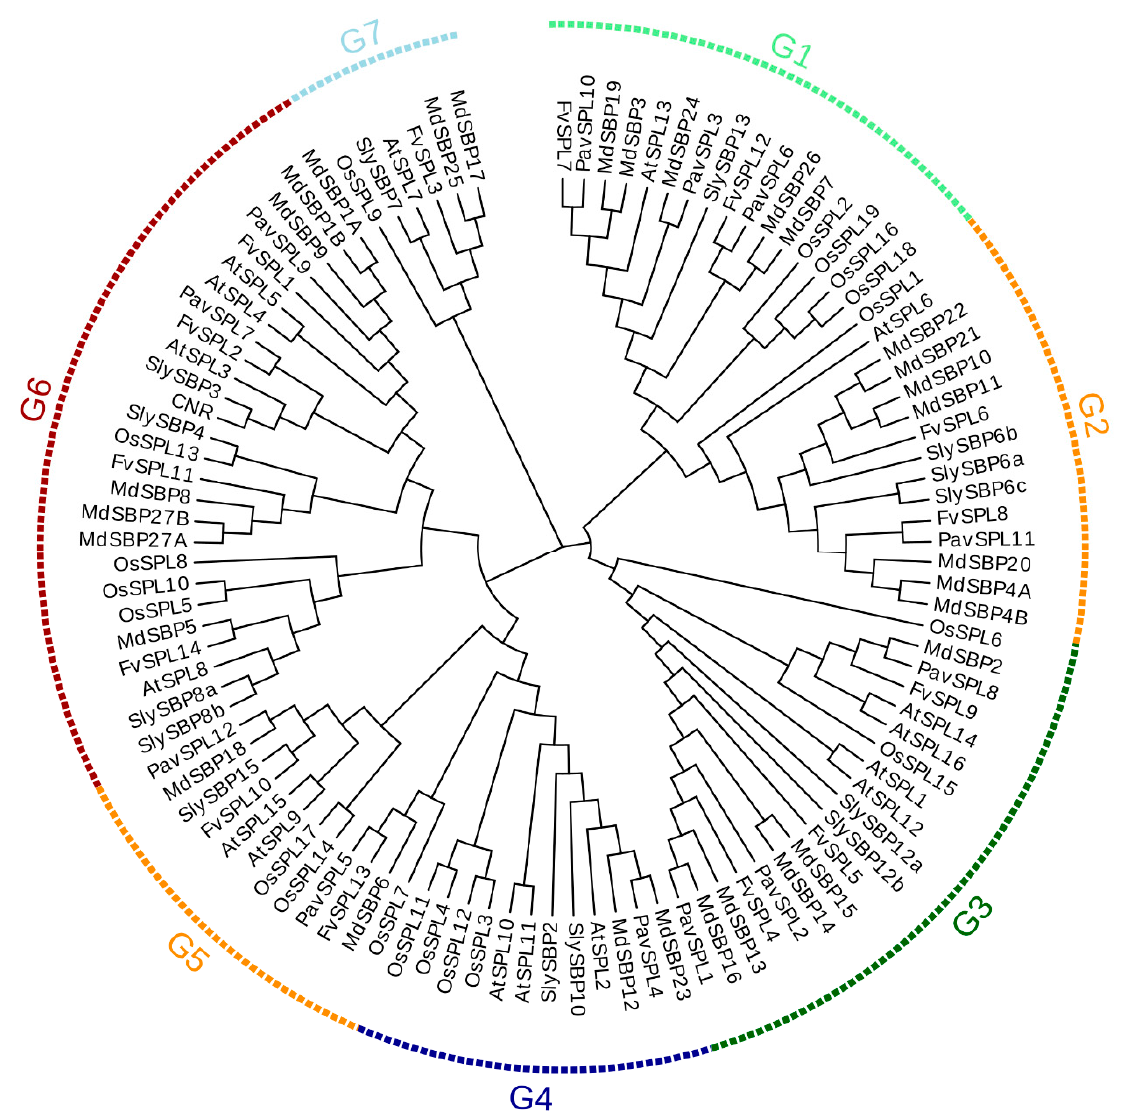
Figure 3. Phylogenetic trees of SPL proteins are from sweet cherry ( PavSPL ), Arabidopsisa ( AtSPL ), tomato ( SlySBP and CNR ), apple ( MdSBP ), rice ( OsSPL ) and strawberry ( FvSPL ) made by neighbor- joining method with bootstrap values from 1000 replicates. G1, G2, G3, G4, G5, G6 and G7 mean Group1, Group2, Group3, Group4, Group5, Group6 and Group7. The sequence and origin of these plants are shown in Supplementary Table S1.